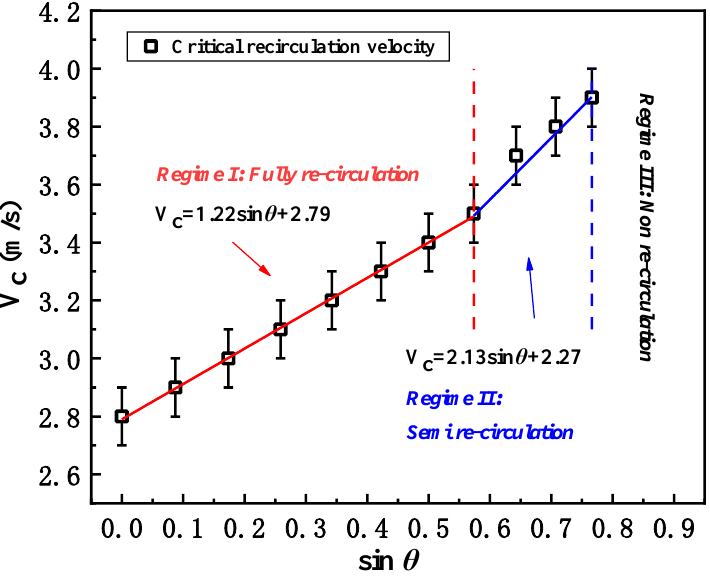
Figure 5. The critical recirculation wind velocity for different wind-direction conditions (the error bars are all ± 0.1 m/s regarding the potential uncertainty caused by visual inspection).